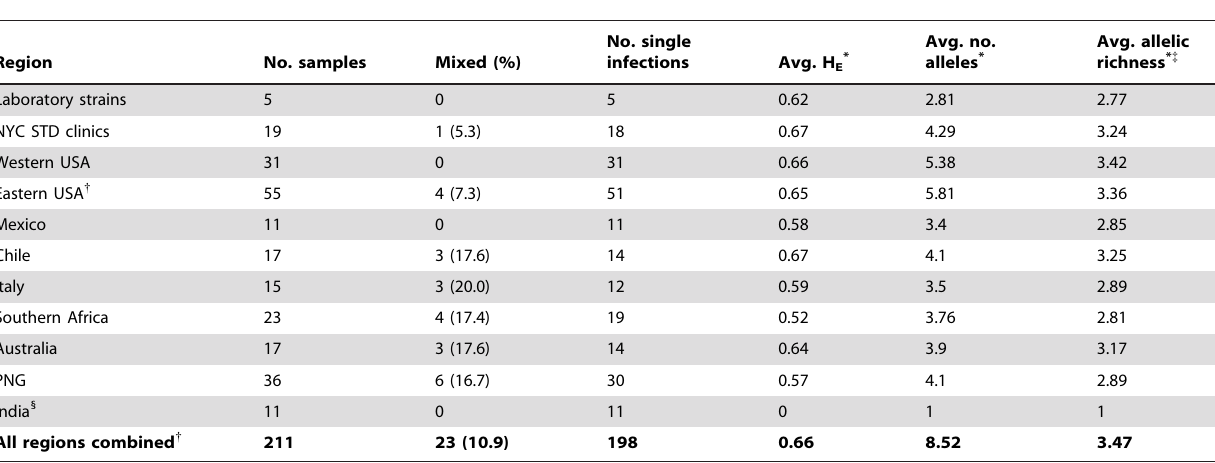
Table 2. Statistics of all T. vaginalis isolates genotyped at 21 microsatellite loci.